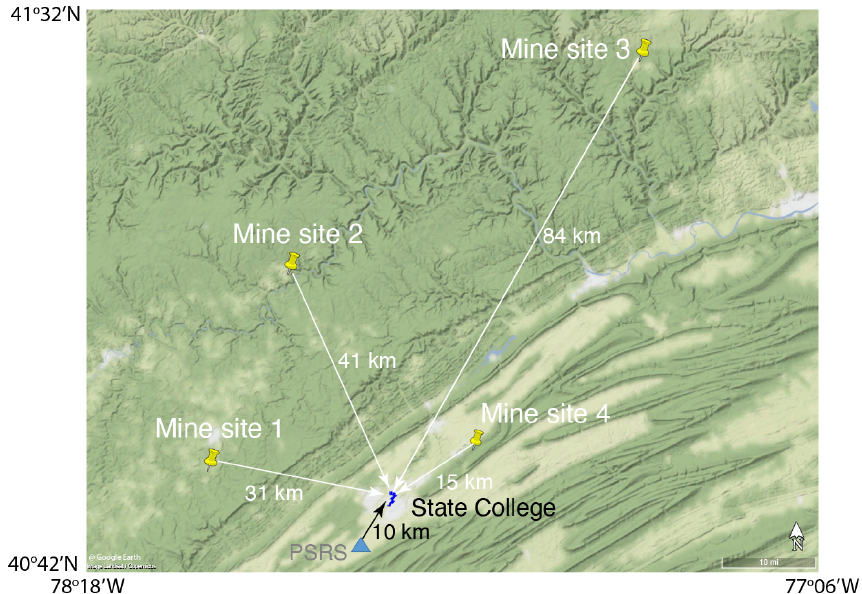
Figure 12. Map of geographical distribution of blast sites (site 1, site 2, site 3 and site 4) around State College. The distances to State College are about 31, 41, 84, and 15km, respectively. Seismic station PSRS, indicated by the blue triangle, is about 10km southwest away from State College. Short blue line is the FORESEE array.